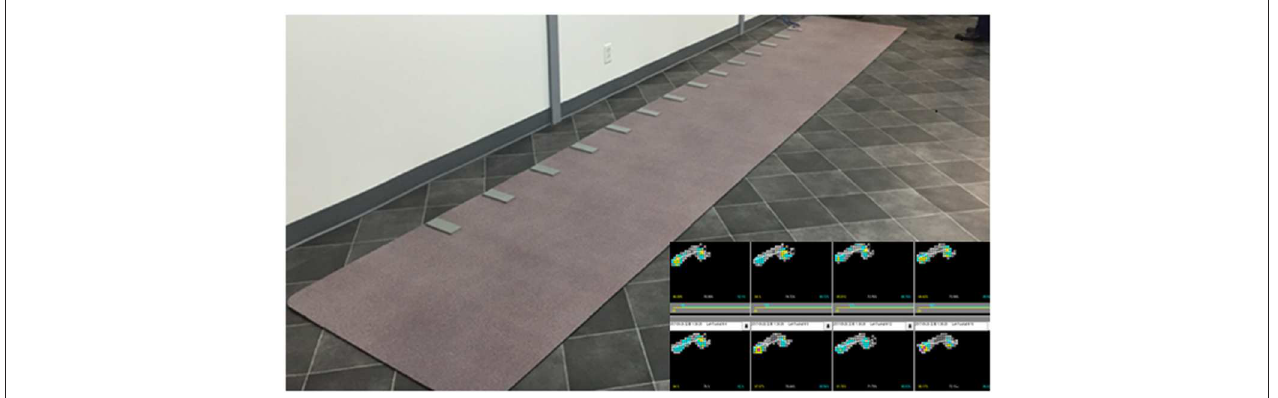
FIGURE 1 | The GAITRite apparatus used in the study.